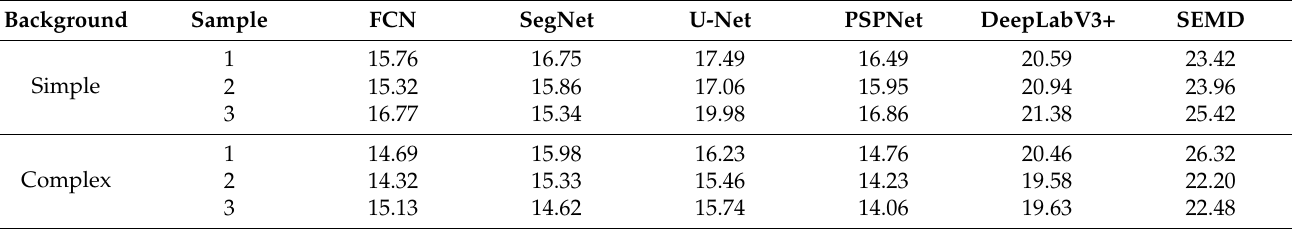
Table 7. PSNR (dB) comparison of different